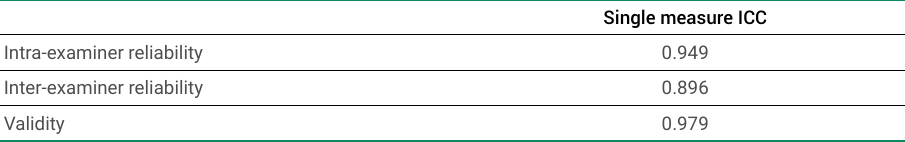
Table 4. Intraclass correlation coefficient of total number counting.